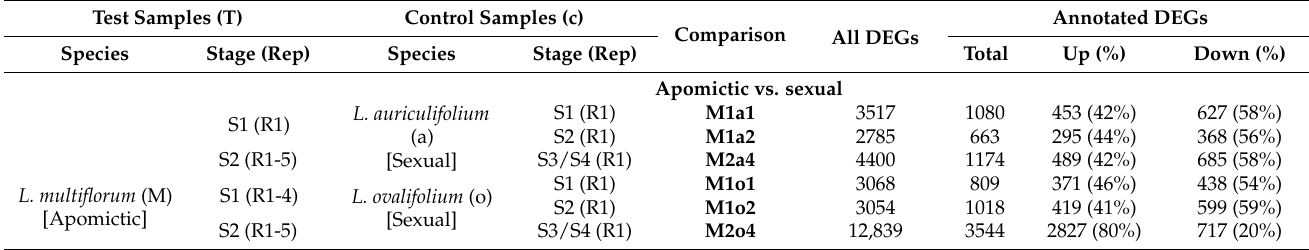
Table 1. List of all tested and control samples of Limonium compared in the differential expression analysis, according to species, reproductive strategy, stage (S), and number of replicates (Rep). Number of all and annotated significantly differentially expressed genes (DEGs) detected by edgeR in Limonium plants, namely apomictic L. multiflorum (M), sexual L. auriculifolium (A/a) and L. ovalifolium (O/o), and facultative apomictic L. dodartii (d), in either stage S1 (1), S2 (2), or S3/S4 (4). All DEGs represent the number of significant genes found to be differently expressed between each test and control sample. DEG annotation was performed according to A. thaliana reference genome. [Comparisons: uppercase refers to test samples, lowercase refers to control samples, and numbers refer to respective